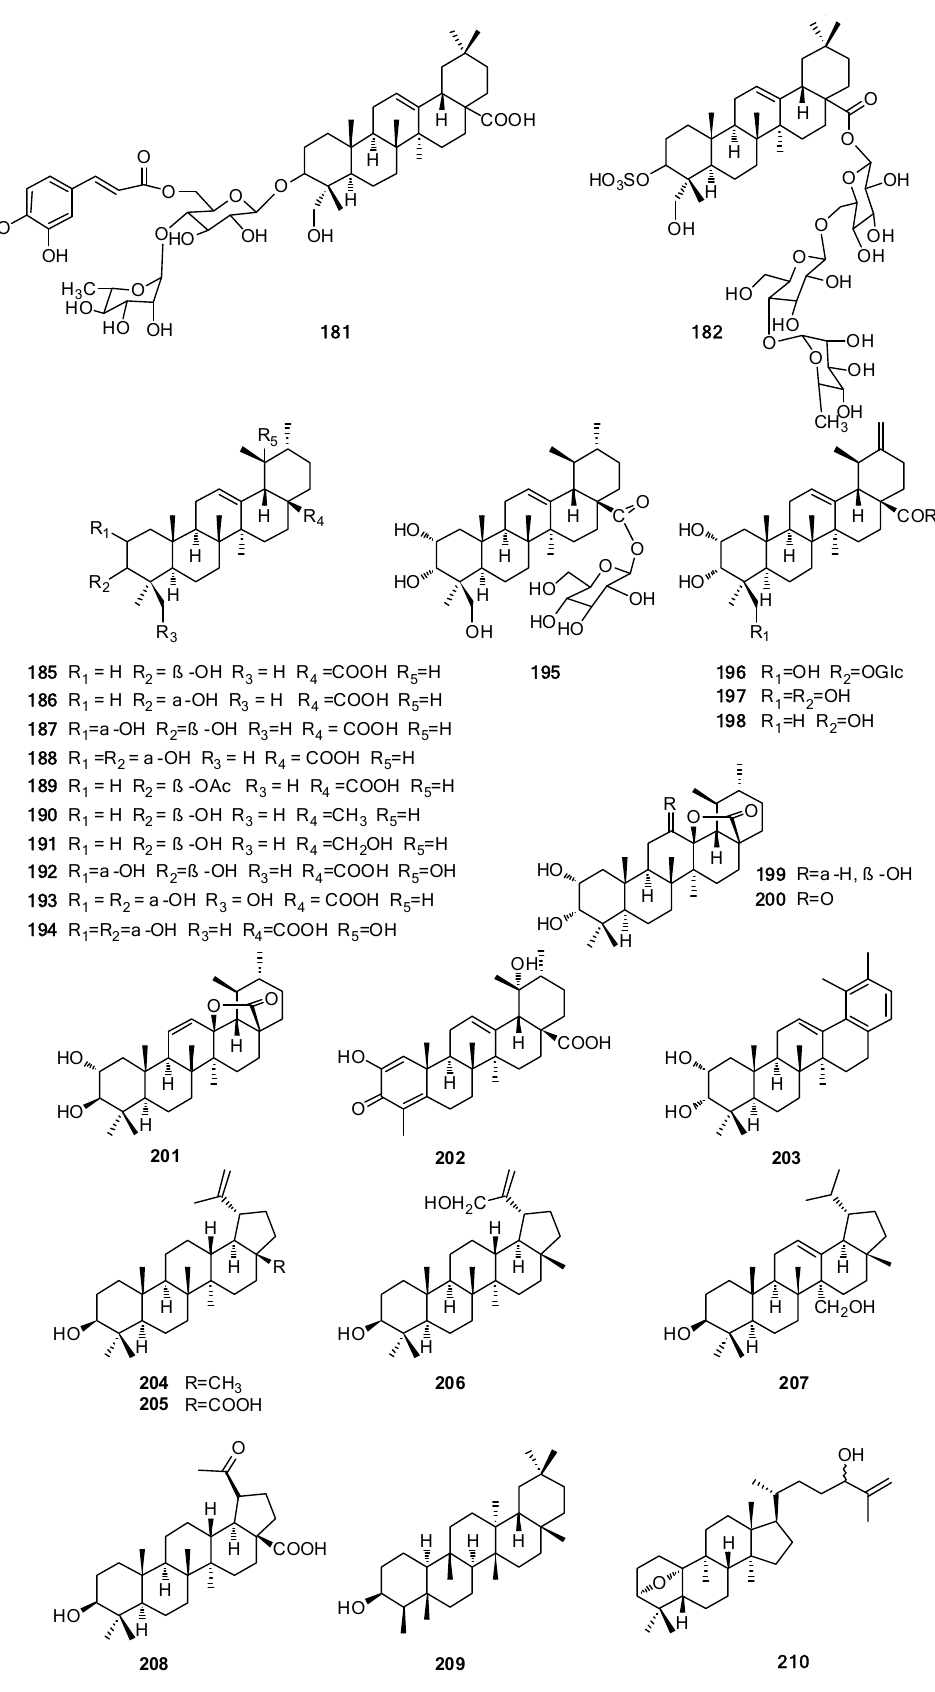
Figure 4. Structures of triterpenoids 157 – 210 isolated from Vitex L.